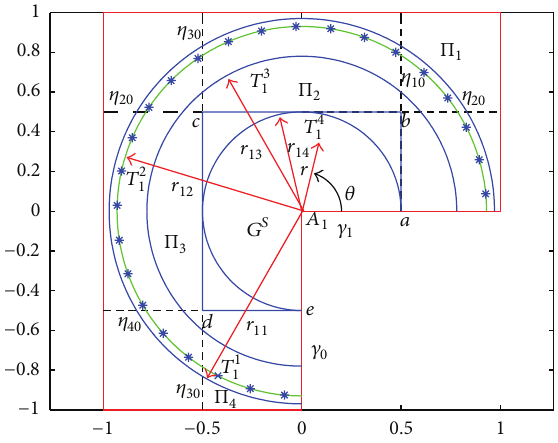
Figure 2: Description of BGM for the L-shaped